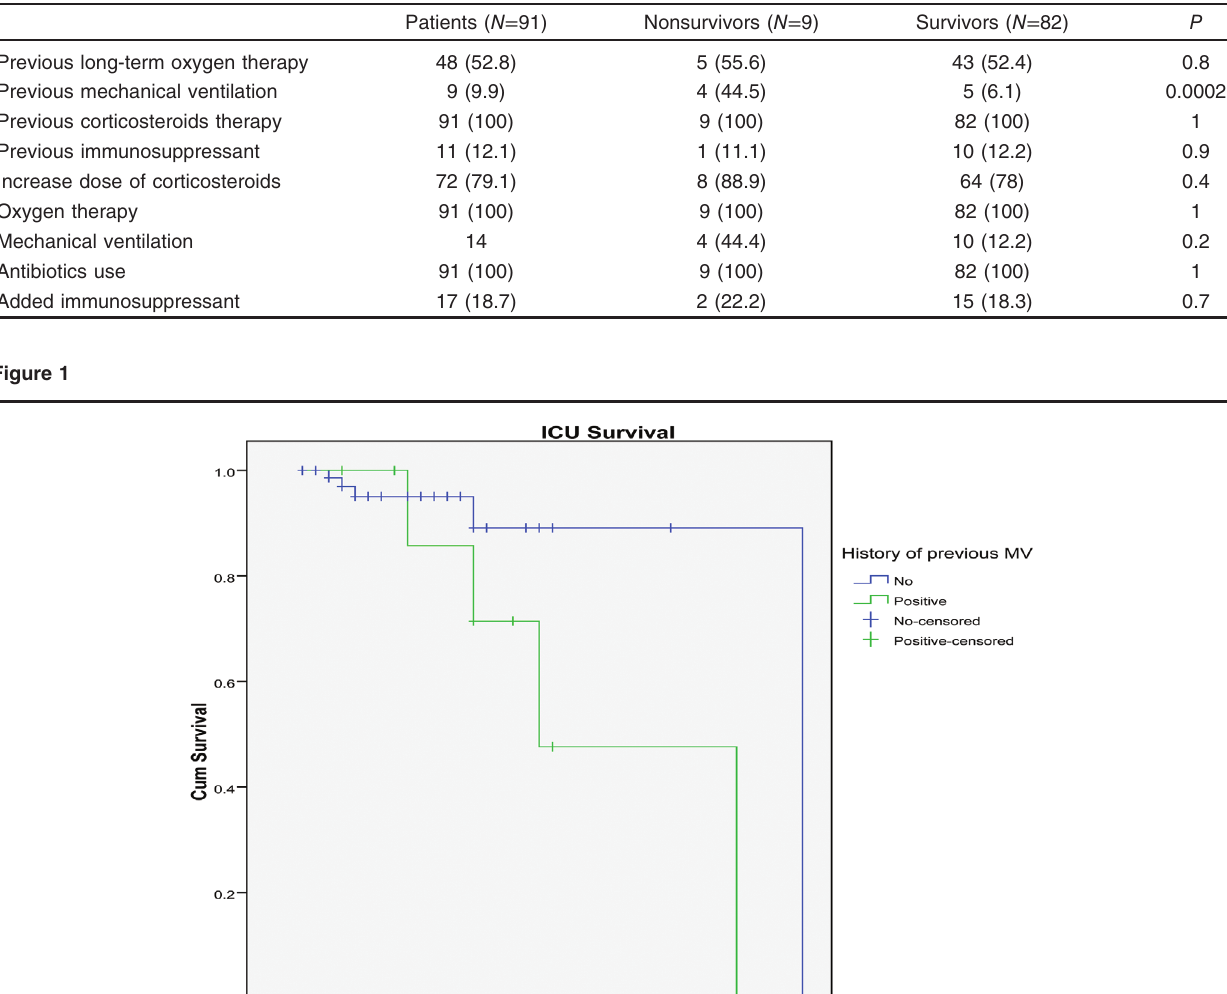
Table 4 Differences in current and previous treatment polices between nonsurvivors and survivors